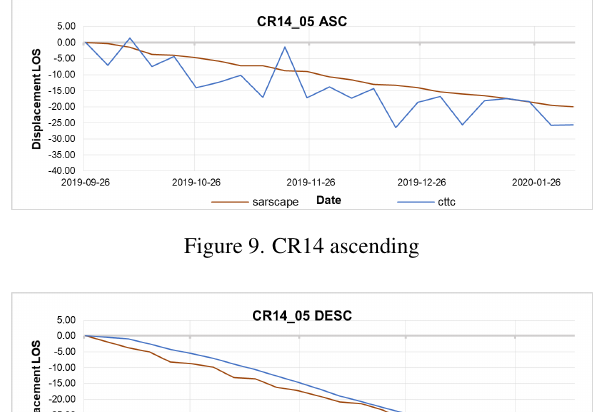
The average difference of the displacements for ASC orbit in time between CTTC and SARScape for CR145 is -4.08 mm (higher bias) and the standard deviation is equal 4.59 mm (high dispersion). The average difference of the displacements for DESC orbit for CR145 is 2.45 mm (smaller bias than ASC) and the standard deviation is equal 1.40mm (smaller dispersion than